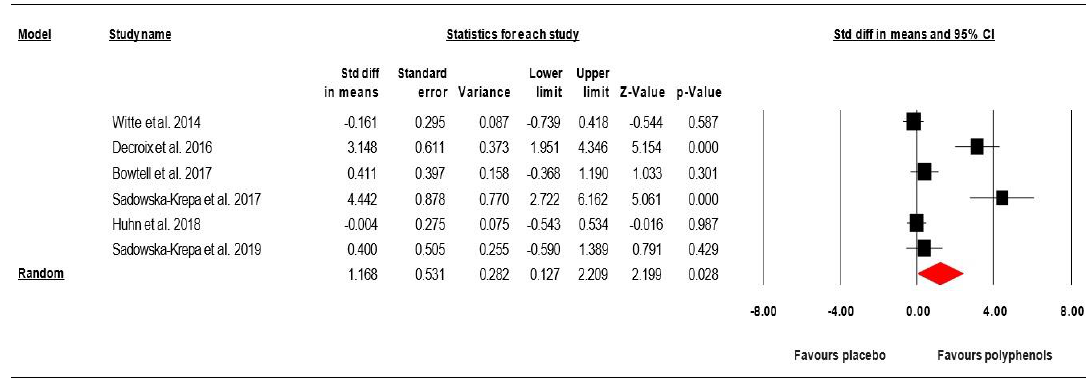
Figure 5. Forest plot including standardized di ff erences in means of e ff ects of (poly)phenols-rich supplementation on BDNF concentrations. Note: Positive direction of ES is indicative a greater e ff ects from (poly)phenols-rich supplementation.